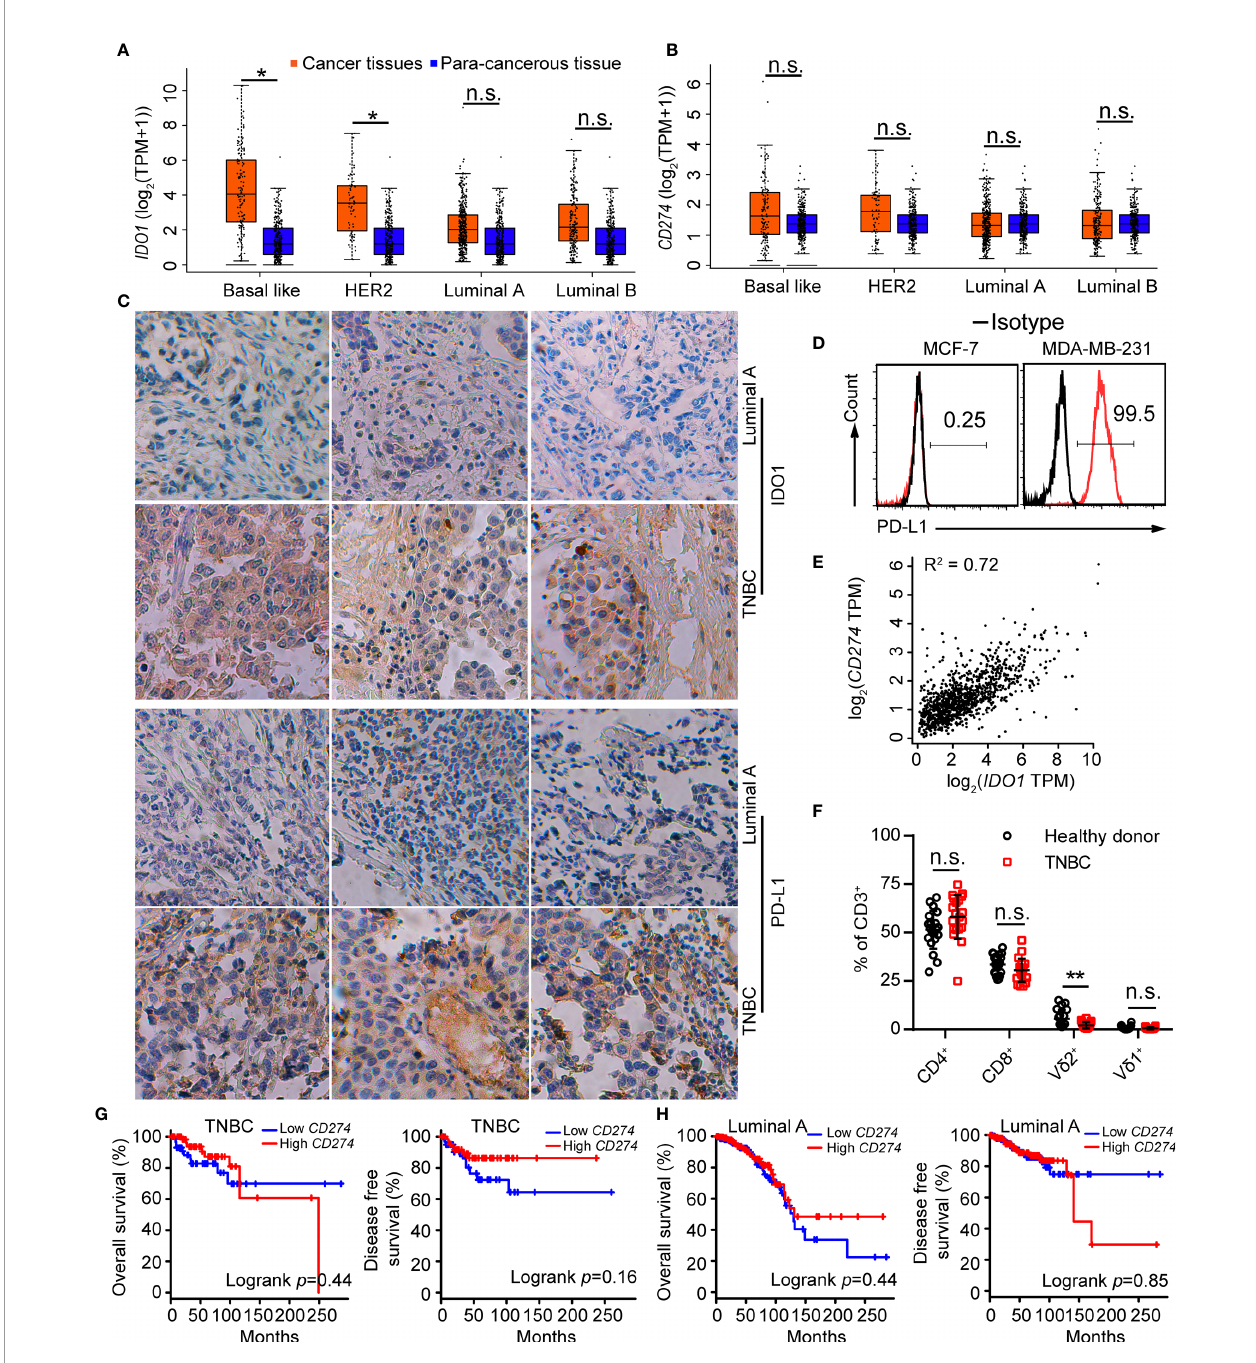
FIGURE 1 | IDO1 and PD-L1 were co-expressed in triple-negative breast cancers. (A, B) Expression of IDO1 and PD-L1 in breast cancers from the GEPIA dataset (Basal like, Cancer tissues ( n =135); HER2, Cancer tissues ( n =66); Luminal A, Cancer tissues ( n =415); Luminal B, Cancer tissues ( n =194); para-cancerous tissues, n =291). Cancer tissues (orange box) labeled as “ tumor ” were compared with para-cancerous tissues (blue box) labeled as “ normal ” . Immunohistochemistry (C) for IDO1 and PD-L1 expression in cancer tissues with luminal A and TNBC ( n =3). (D) Representative histograms of PD-L1 expression by MCF-7 (luminal A) and MDA- MB-231 (TNBC) cells. (E) Correlation between PD-L1 and IDO1 expression in human breast cancer samples from the GEPIA ( n =1085; R 2 = values by linear regression). (F) Dot plots showing T cell subsets isolated from healthy or patient donors with TNBC PBMCs, expressed as percentage of CD3 + cells ( n =20). (G) Overall survival and disease-free survival of triple-negative breast cancer patients with high or low CD274 ( PD-L1 ) expression ( n (high)=67, n (low)=67) as de fi ned by the median. Compared by log-rank (Mantel-Cox) test (GEPIA data base). (H) Overall survival and disease-free survival of luminal A breast cancer patients with high or low CD274 ( PD-L1 ) expression ( n (high)=205, n (low)=205) as de fi ned by the median. Compared by log-rank (Mantel − Cox) test (GEPIA data base). Unpaired Student ’ s t -test (F). Signi fi cance was set to P < 0.05 and represented as * P < 0.05, ** P < 0.01, *** P < 0.001, and **** P < 0.0001, n.s. , not signi fi